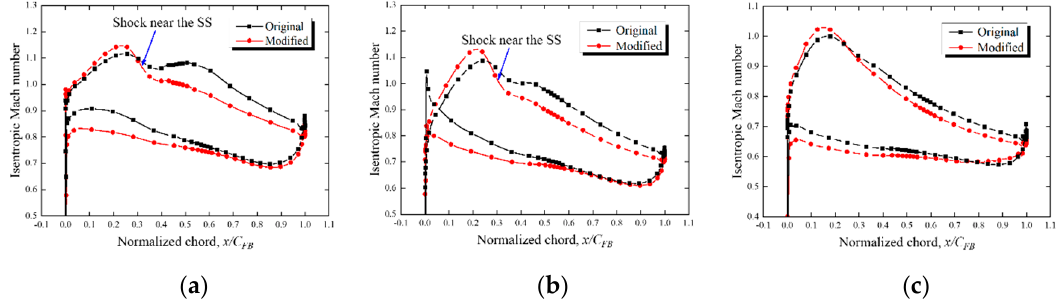
Figure 26. FB surface isentropic Mach number at 100% design speed at the DE point. ( a ) 10% blade height; ( b ) 50% blade height; ( c ) 90% blade